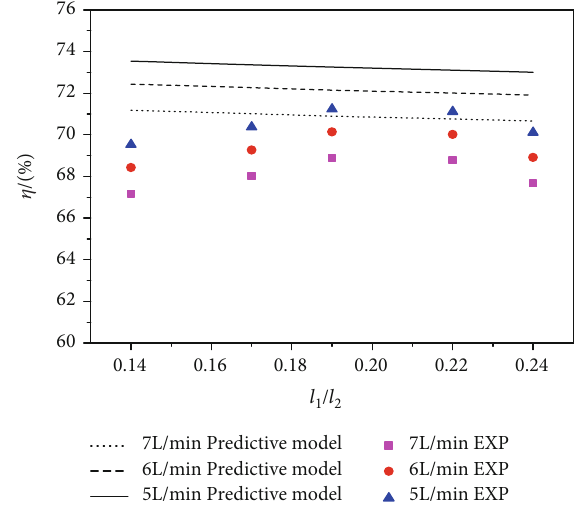
Figure 7: Comparison of separation e ffi ciency at di ff erent outlet trachea lengths.